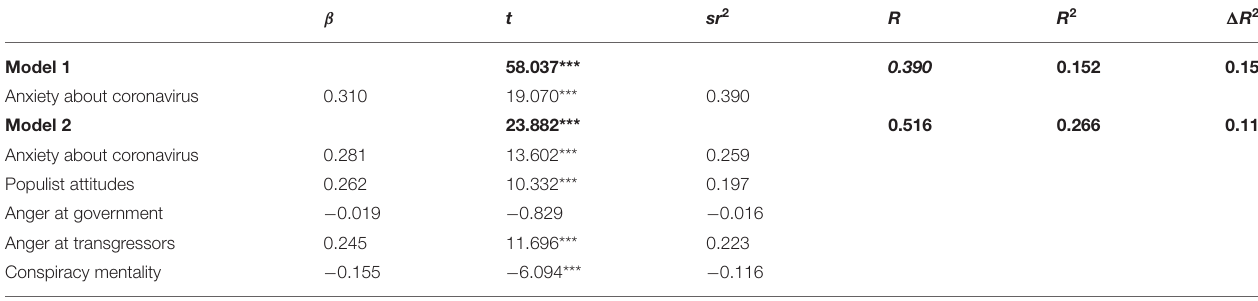
TABLE 4 | Hierarchical regression analysis for “support for hygiene measures” in three steps (standardized regression coefficients).